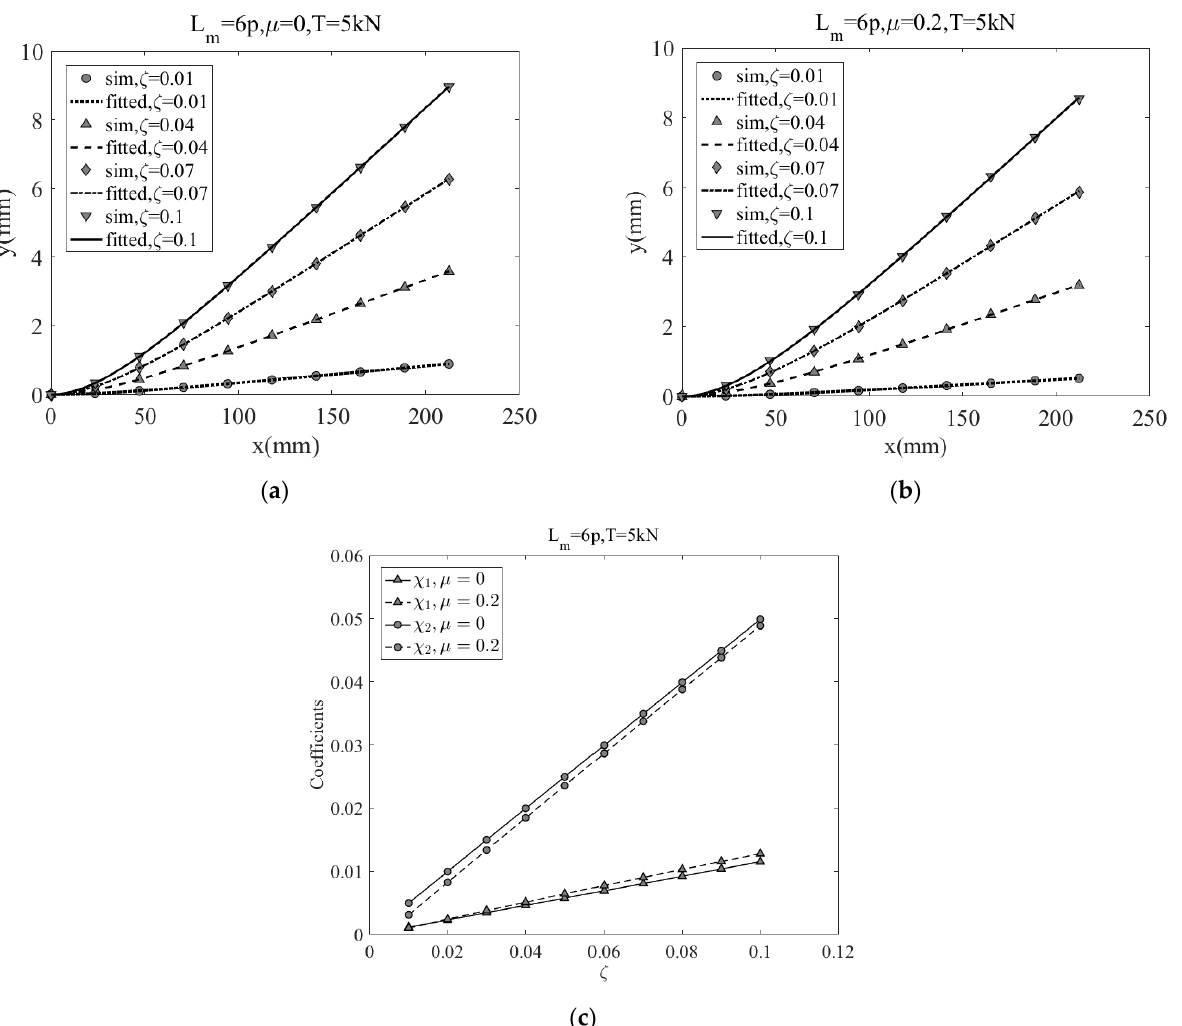
Figure 10. Comparison of simulation deflection curves and fitted curves for 6p-length strands with different friction coefficients ( a ) μ = 0 and ( b ) μ = 0.2; ( c ) the corresponding fitting coefficients of the simulation deflection curves.